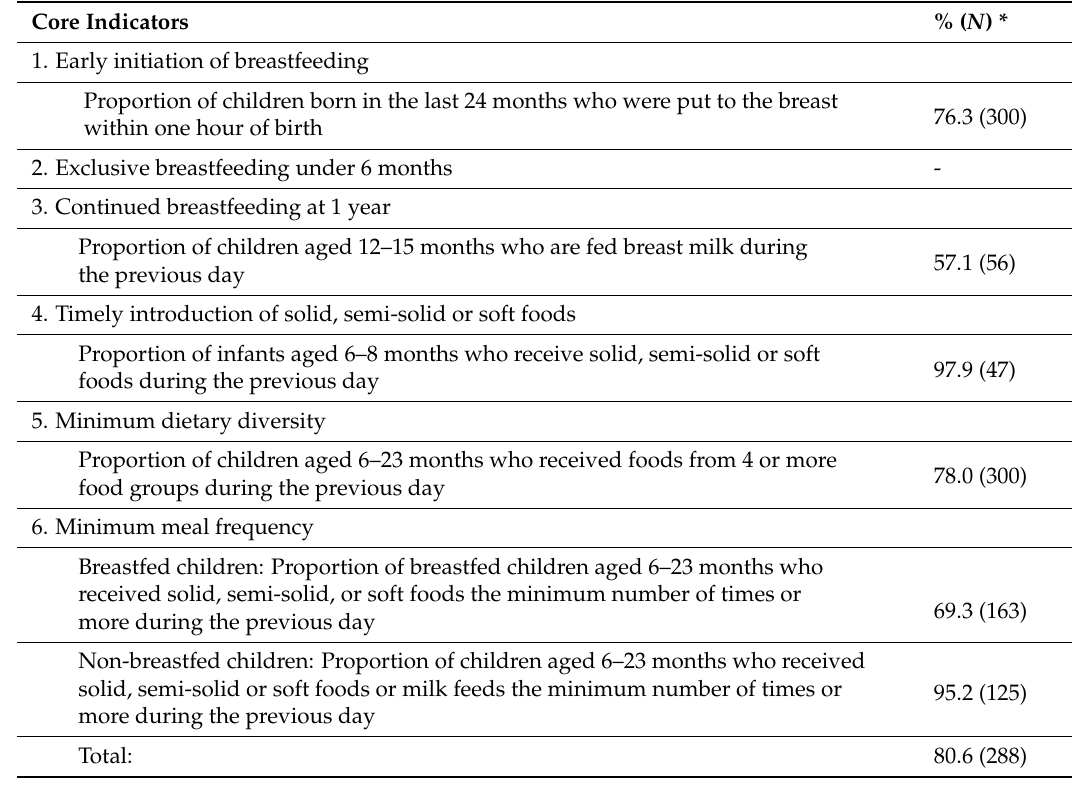
Table 1. Compliance (%) with WHO IYCF indicators [1] (WHO, 2010) by total sample ( N = 300). Core Indicators % ( N )